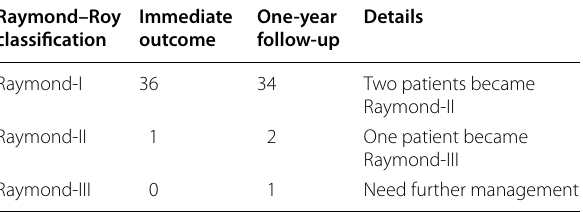
Table 3 Immediate radiological outcome and 1‑year follow‑up in 37 patients (excluding 3 patients treated by flow diverters) Raymond–Roy